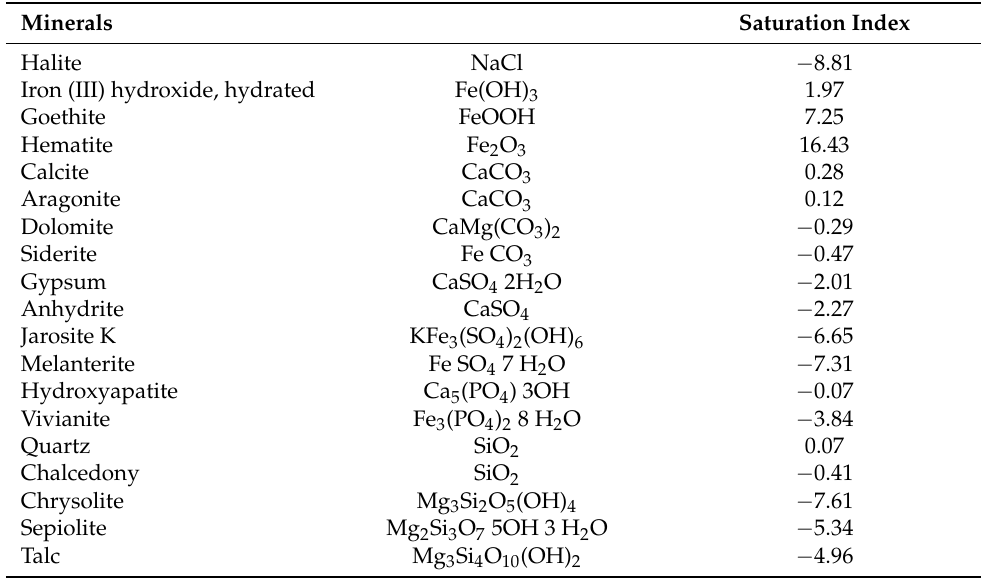
Table 3. Average values of the saturation indexes (SI) in relation to minerals in the waters of the springs of the Knyszyn